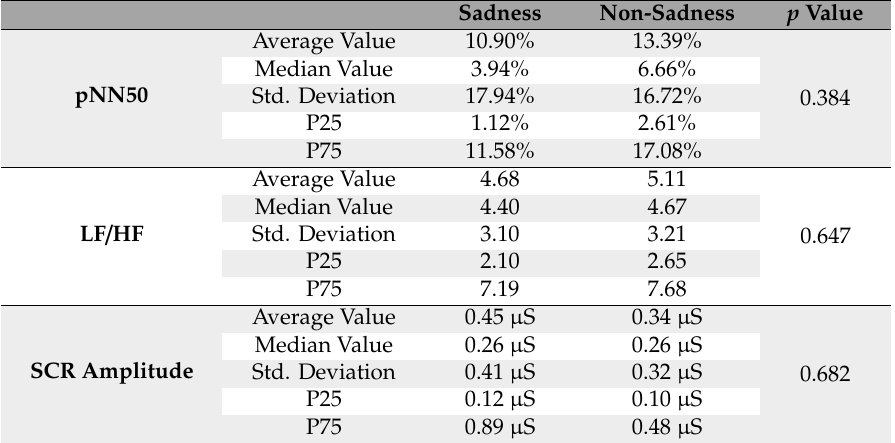
Table 8. Heart rate variability and skin conductivity during the driving test grouped by sadness level. Sadness